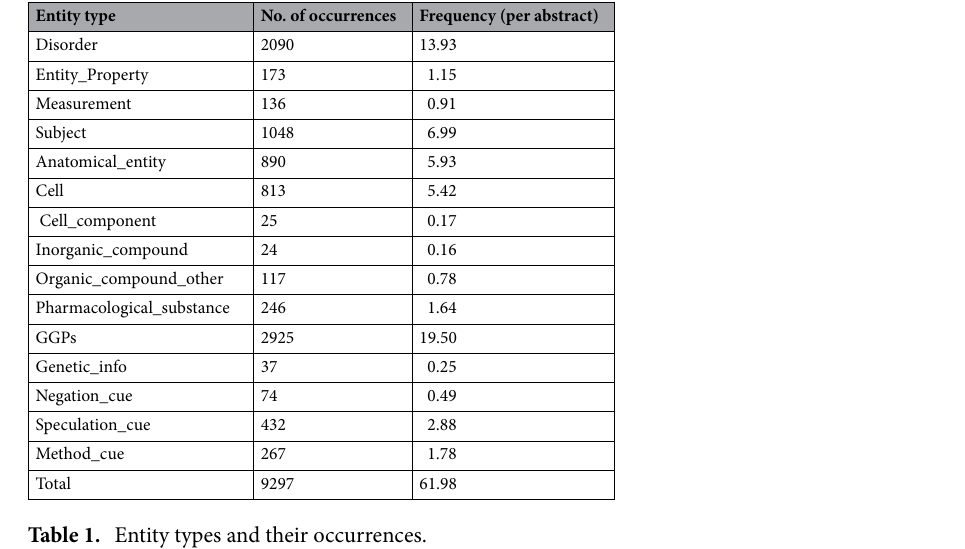
Table 1. Entity types and their